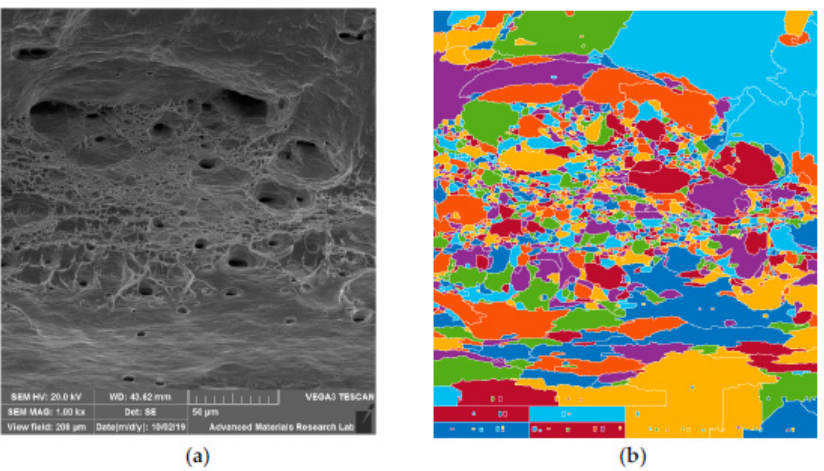
Figure 17. Dimple size analysis for HT specimen: ( a ) SEM image at 1000 × ; ( b ) Processed image.